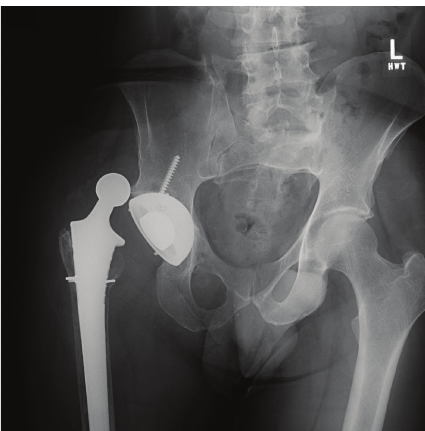
Figure 1: Ten year old hip with dislocation.